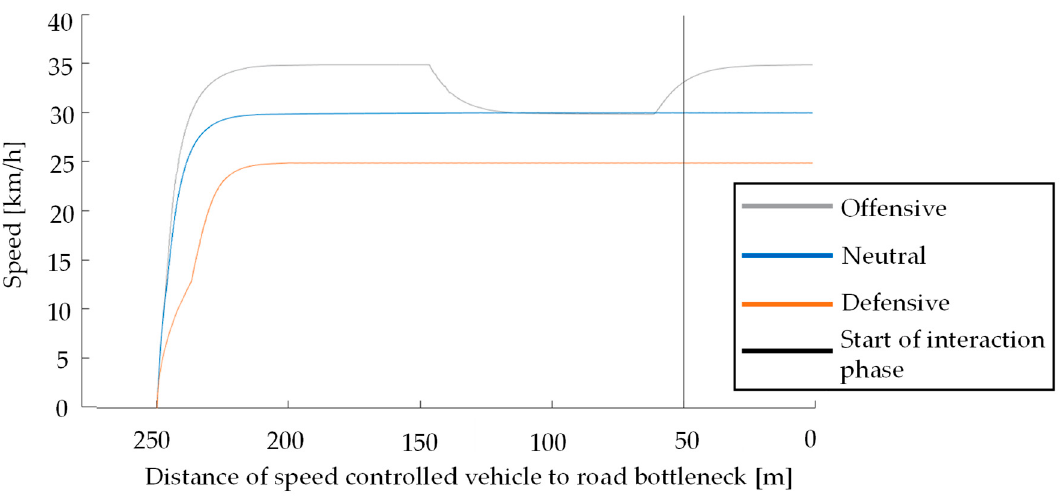
Figure 3. Three di ff erent implemented speed profiles (o ff ensive, neutral, defensive) using a cruise Figure 3. Three different implemented speed profiles (offensive, neutral, defensive) using a cruise control to simulate the manual vehicle during the control to simulate the manual vehicle during the pre-test.